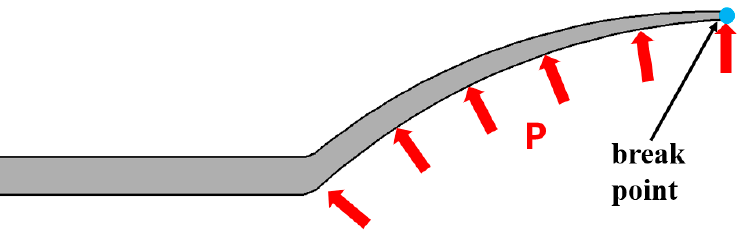
After bulging, the shape of the tube from the perspective of the XOY plane is shown in Figure 5. For the bulging phase, it is generally assumed that the stress-strain is evenly distributed along the wall thickness. The radial stress is ignored. Only the tangential tensile stress is considered.